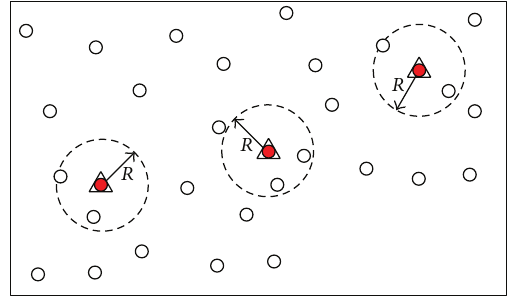
Figure 1: Mobile anchor assisted